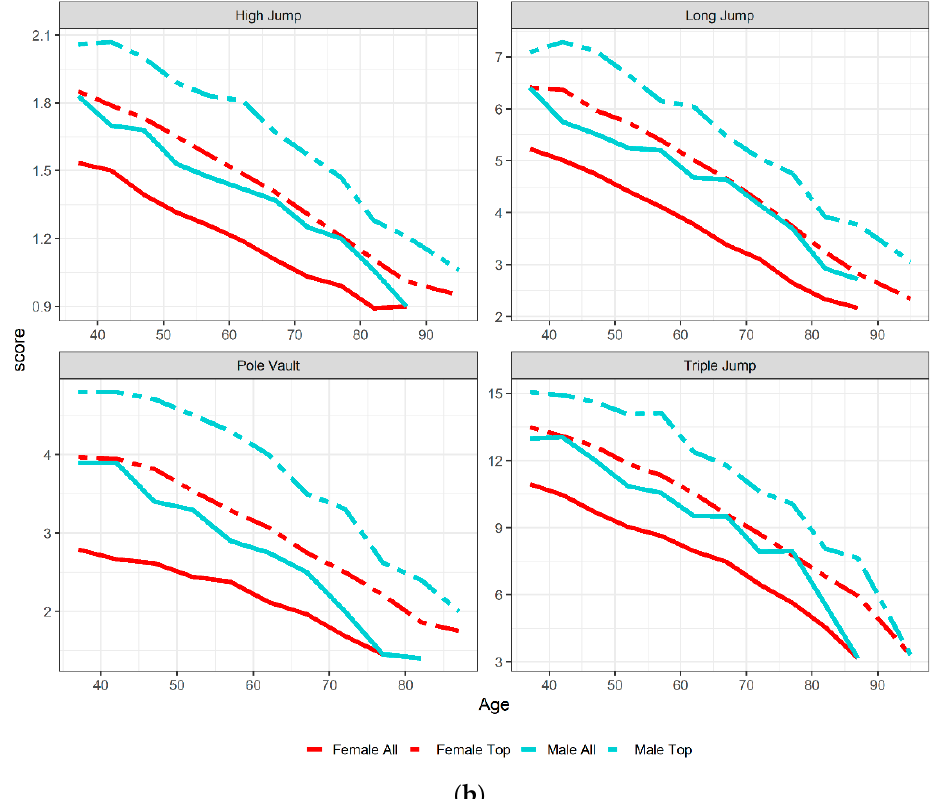
Figure 3. The decline with age of mean score (all athletes) and top score in throwing ( a ) and jumping ( b ) events by sex. Age was defined as a continuous variable, considering the middle of the interval of each age group.